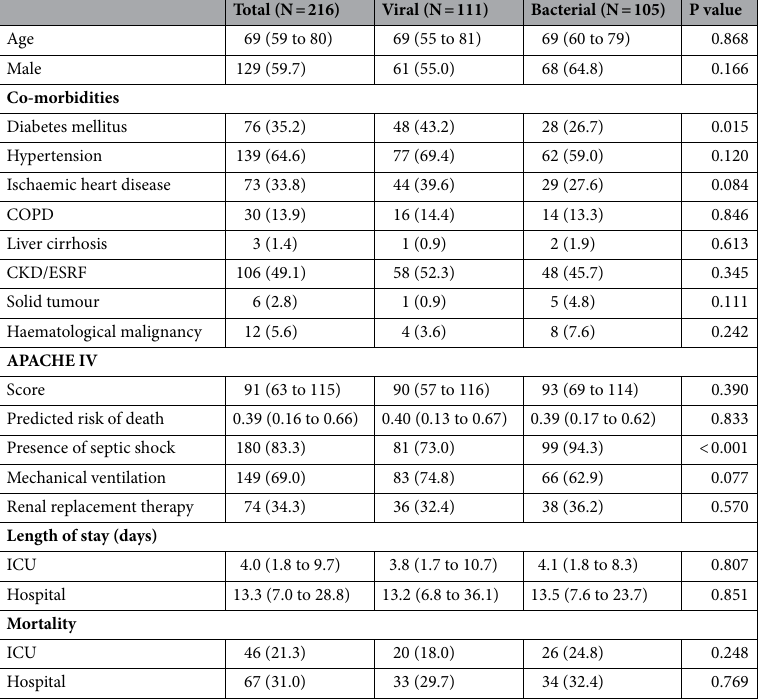
and these patients were more likely to have septic shock (92.5% vs. 79.2%, P = 0.017), received mechanical venti- lation (83.6% vs. 62.4%, P = 0.002), required renal replacement therapy (47.8% vs. 28.2%, P = 0.008), and shorter hospital lengths of stay (11.1 vs. 14.1, P = 0.012). Univariate analysis of laboratory parameters (Table 2) showed that lymphocytes at 0 h and 48 h and their delta and that monocytes at 48 h and platelets at 0 h and 48 h and their delta were significantly lower in non-survivors. NLR at 48 h and its delta and RDW at 0 h and 48 h were significantly higher in non-survivors. Prognostic performance of laboratory parameters. The prognostic power of the significant param- eters identified in univariate analysis was compared with the APACHE IV score, and APACHE IV predicted risk of death by ROC analysis (Table 3). APACHE IV predicted risk of death (AUC 0.776, 95% CI 0.713–0.84), and the APACHE IV score (AUC 0.769, 95% CI 0.705–0.833) had the highest discriminatory ability for the predic- tion of hospital mortality. Platelets at 48 h performed the best among the laboratory parameters assessed in predicting hospital mortality (AUC 0.721, 95% CI 0.643–0.798). Variables that were associated (P < 0.1) with hospital mortality in the initial univariate analysis (Table 2) were included in multivariate analysis. Table 4 shows the logistic regression analysis of predictors of hospital mortality. Independent predictors of hospital mortality included age (odds ratio 1.052, P = 0.001), APACHE IV score (OR 1.020, P = 0.001), RDW at 48 h (OR 1.268, P = 0.011), delta NLR (OR 1.019, P = 0.051) and platelet count at 0 h (OR 0.994, P = 0.013). The Hosmer ‒ Lemeshow test was used to ensure the goodness of fit of statistical models, with a p value of 0.814, which indicated good calibration and model fit. The composite of the 5 parameters in Table 4 was referred to as Model 1. Figure 1 compares the prognostic performance of Model 1 and the APACHE IV score by ROC analysis. Model 1, being a composite of five inde- pendent predictors, showed superiority in predicting hospital mortality (AUC 0.830, 95% CI 0.772–0.888) over the APACHE IV score alone (AUC 0.769, 95% CI 0.705–0.833). Classification tree analysis. The classification tree model (Fig. 2) was applied to analyse determinant factors that predict hospital mortality. The most significant predictor was the APACHE IV score (adjusted P = 0.000, χ 2 = 35.591). For patients with APACHE IV scores ≤ 70, those requiring mechanical ventilation had increased hospital mortality (adjusted P = 0.014, χ 2 = 5.999, hospital mortality rate of 14% vs. 0% compared with those not requiring mechanical ventilation). For patients with APACHE IV scores > 90 and ages > 78 (adjusted P = 0.007, χ 2 = 11.221), the hospital mortality rate reached 67.4%. For patients with APACHE IV score > 90 and age ≤ 78, platelet count (adjusted P = 0.004, χ 2 = 12.316) became an important determinant of mortality. Those with platelet counts ≤ 128 at 0 h had higher hospital mortality (59.3% vs. 16.7%) than those patients with platelet counts > 128.